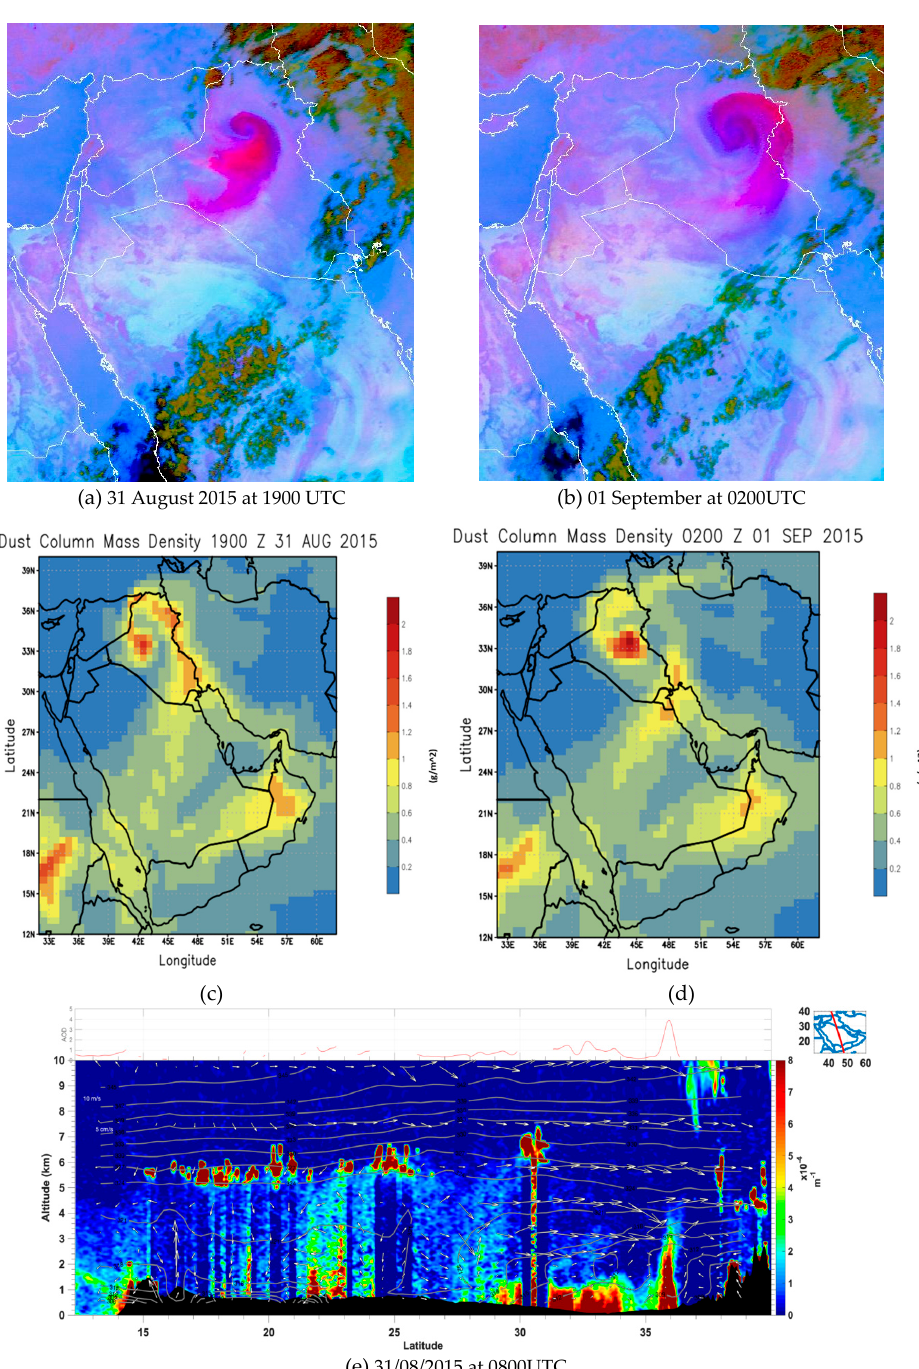
Figure 4. SEVIRI-derived false color images showing dust (pink/purple), clouds (brown/red) and differences in surface emissivity retrieved in absence of dust or clouds (light blue/blue) on: ( a ) 31 August 2015 at 1900 UTC and ( b ) 01 September at 0200UTC. Dust mass column density derived from MERRA2 re-analyses on ( c ) 31 August 2015 at 1900 UTC and ( d ) 01 September at 0200UTC. ( e ) CALIPSO observations on 31 August 2015 at 0800UTC of particle extinction coe ffi cient at 532 nm on which are superimposed the wind direction and vertical velocities in vectors and the isentropes derived from ECMWF ERA5 re-anlayses along CALIPSO track. The upper panel shows the AODs derived from CALIPSO at 532 nm along its path on 31 August 2015. The panel in the upper-right corner shows in red the path of CALIPSO over the study area on 31 August 2015 at